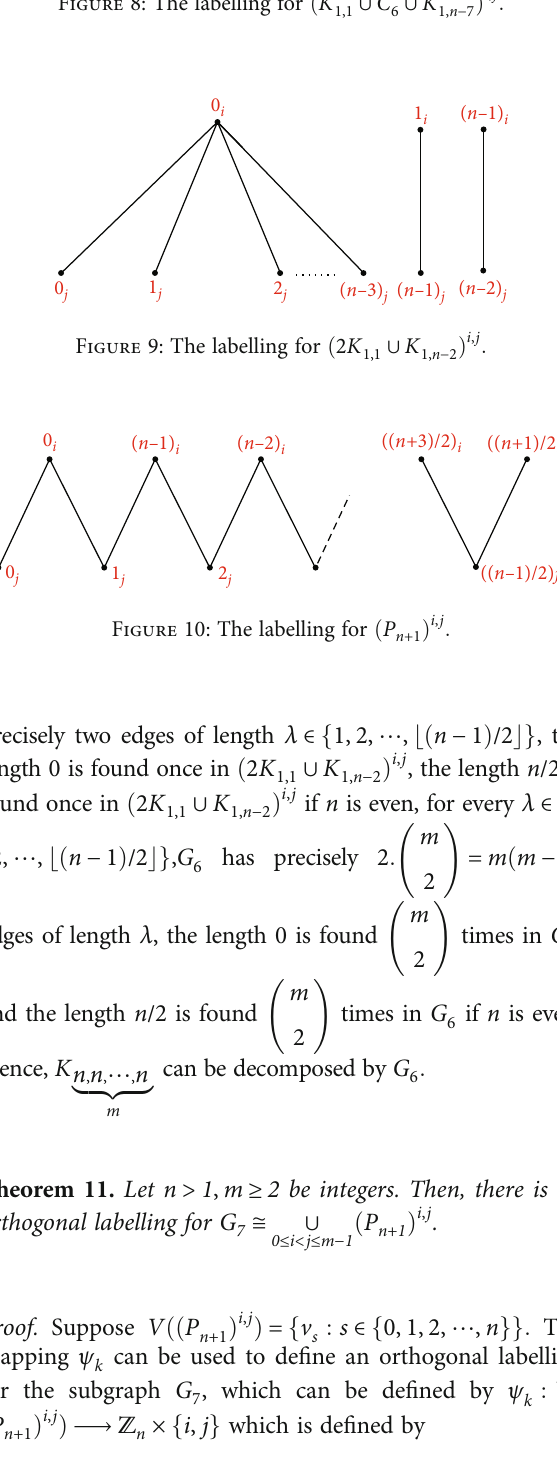
Figure 8: The labelling for ð K